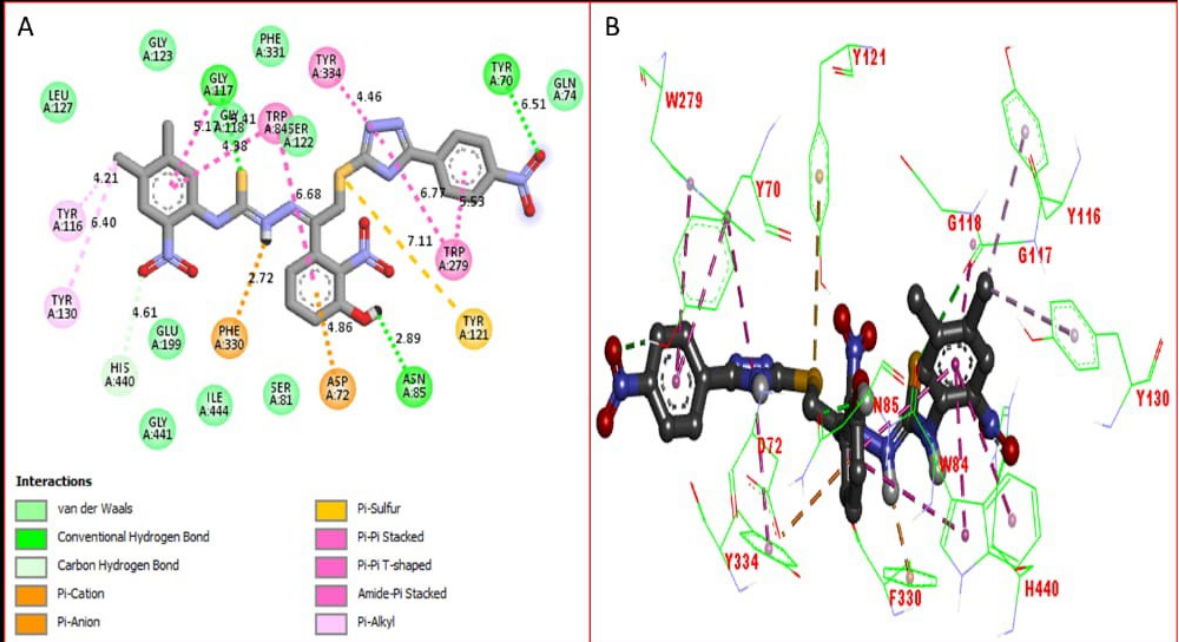
Figure 6. Protein–ligand interaction (PLI) profile of analogue 6i against butyrylcholinesterase (BuChE): ( A ) 2D; ( B ) 3D.